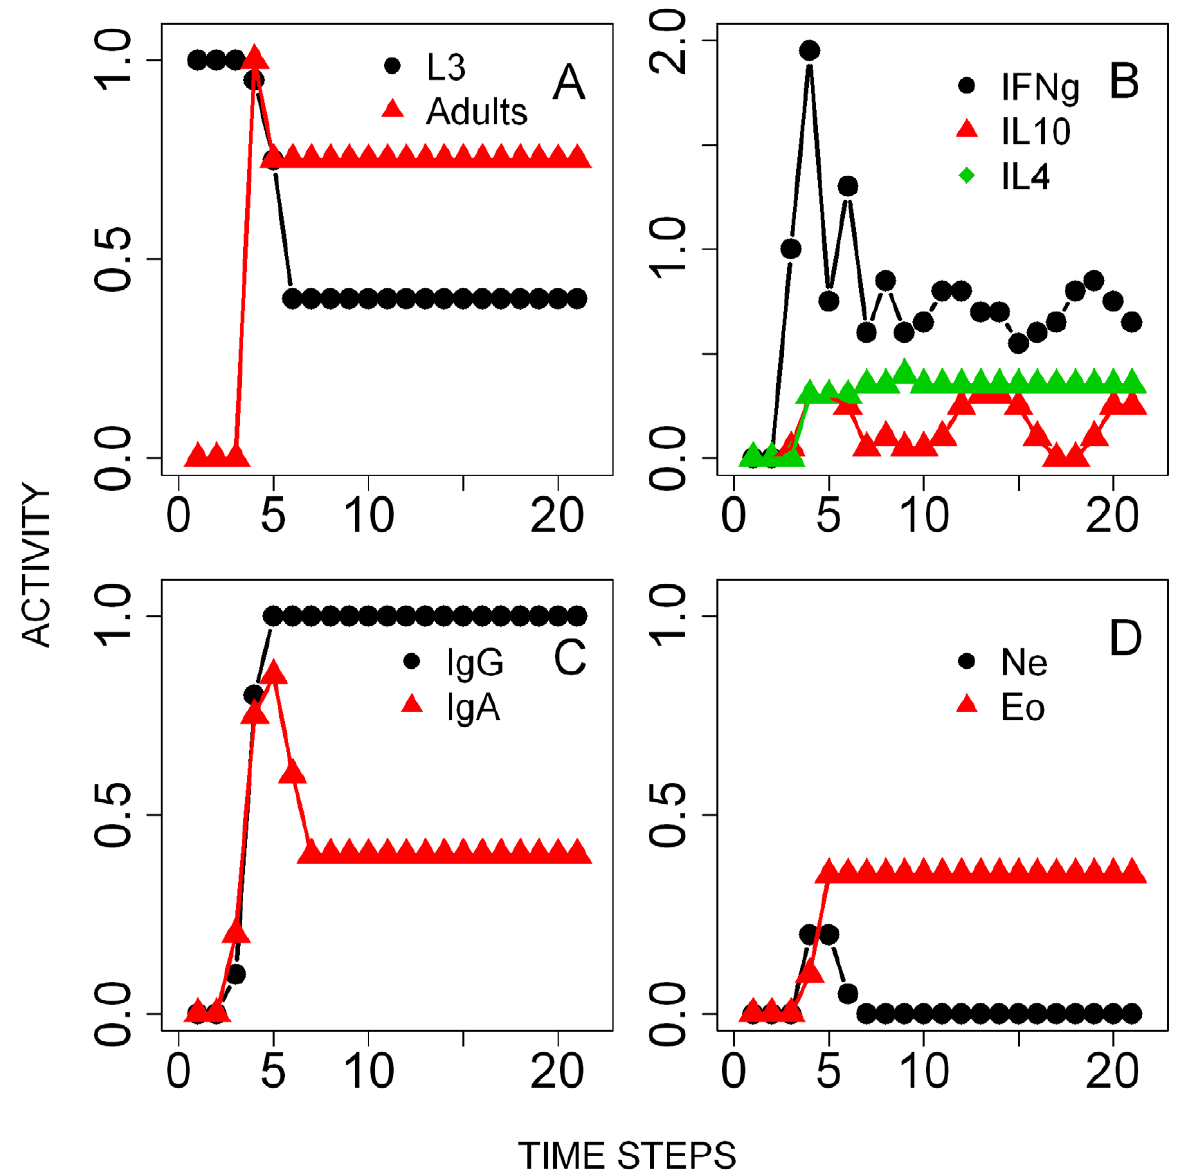
Figure 5. Results of the simulations of the time course of the single T.retortaeformis infection. Activity profiles (the probability of the node being in an ON state at a given time-step) are reported for: A - Third stage infective larvae (L3) and adults. B - Cytokines, IFN c , IL4 and IL10 in the duodenum. C - Mucus antibodies against helminth adult parasites. D - Peripheral eosinophils and neutrophils. Note that the IFN c concentration range is between 0–2 to describe additional non-immune mediated activation of that node by the tissue damage (details in the